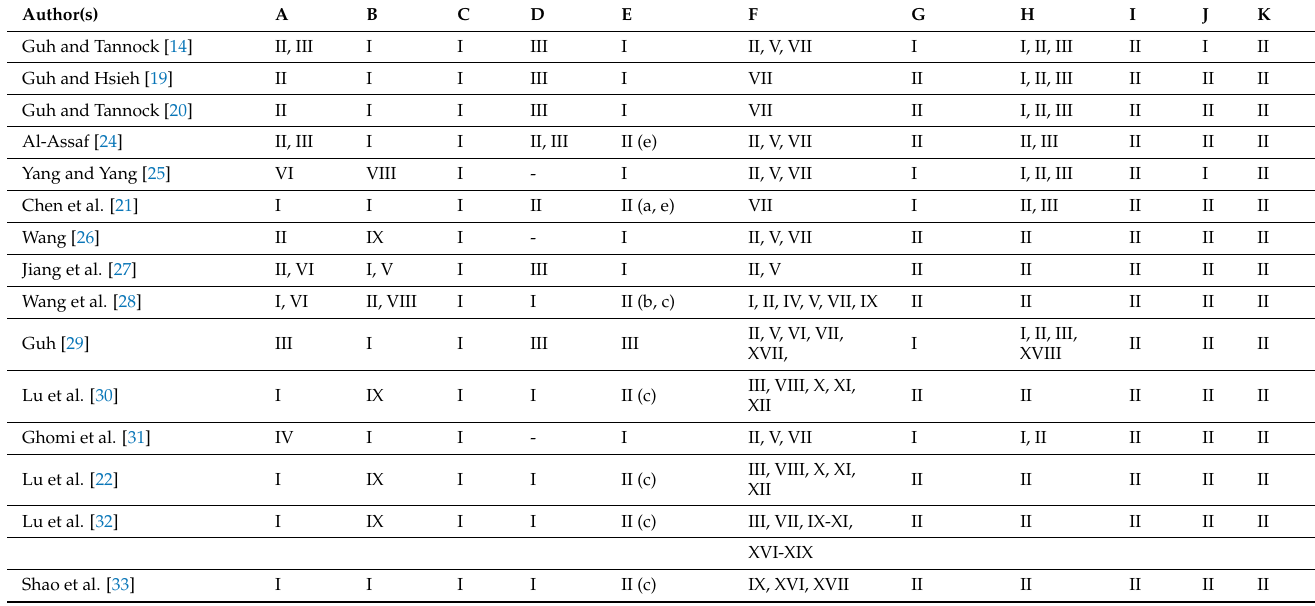
Table 1. Indexing of reviewed